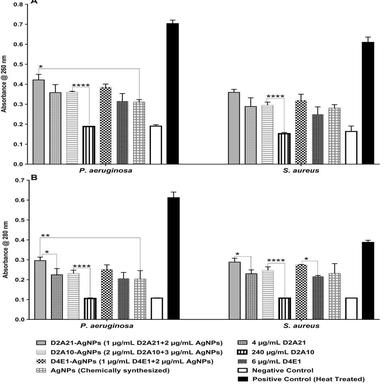
UV–visible absorption at 260 nm (A) and 280 nm (B) of intracellular materials released from P. aeruginosa, S. aureus treated with P-AgNPs, native peptides and chemically synthesized AgNPs. Positive and Negative controls were maintained as bacterial cell suspensions with heat treatment (in boiling water bath for 30 min) and no drug treatment, respectively. The statistical significance was observed between P-AgNPs and native peptides; P-AgNPs and chemically synthesized AgNPs. ⁎ P < 0.05 and ⁎⁎⁎⁎P < 0.0001 whe